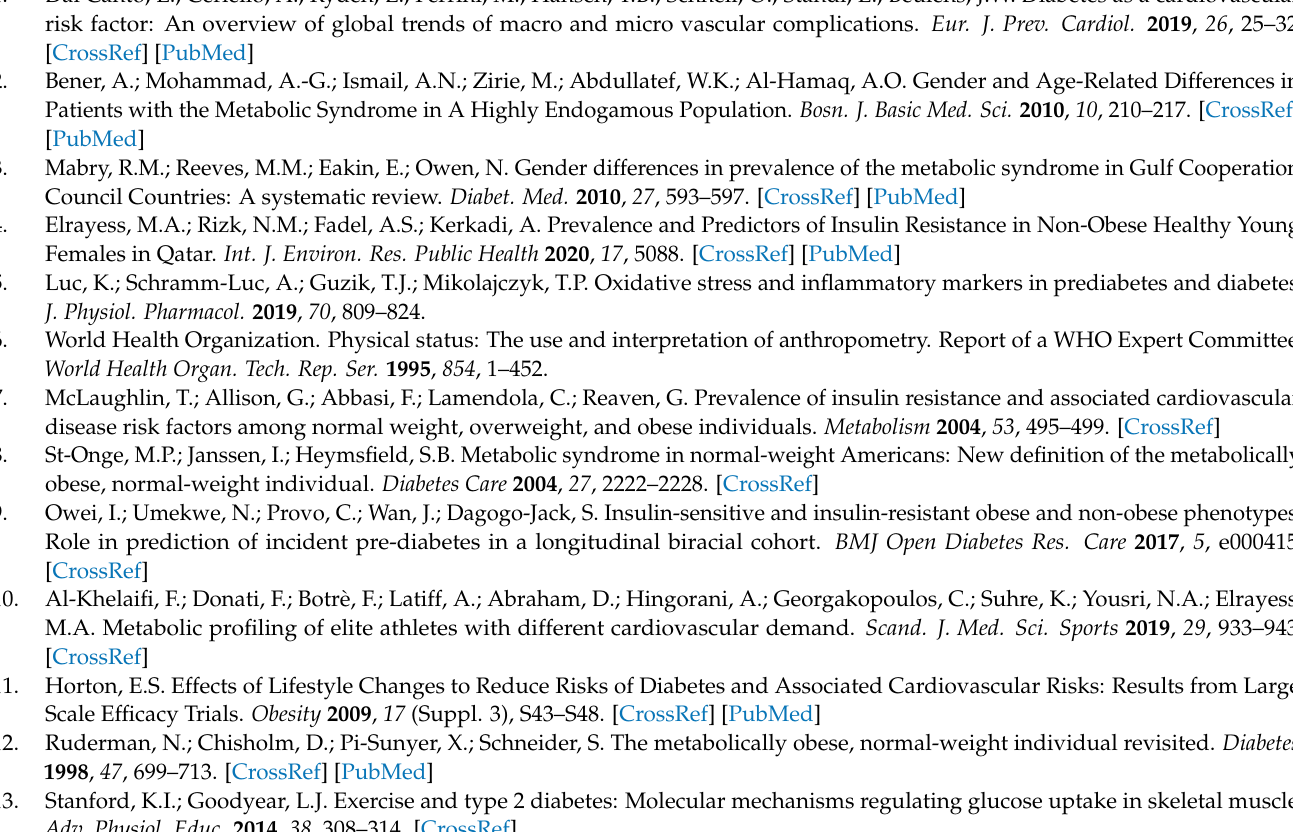
category; Table S2: linear regression analysis assessing the difference in metabolic profiles between physically active and sedentary females in each HOMA-IR category. SE: standard error; FDR: false discovery